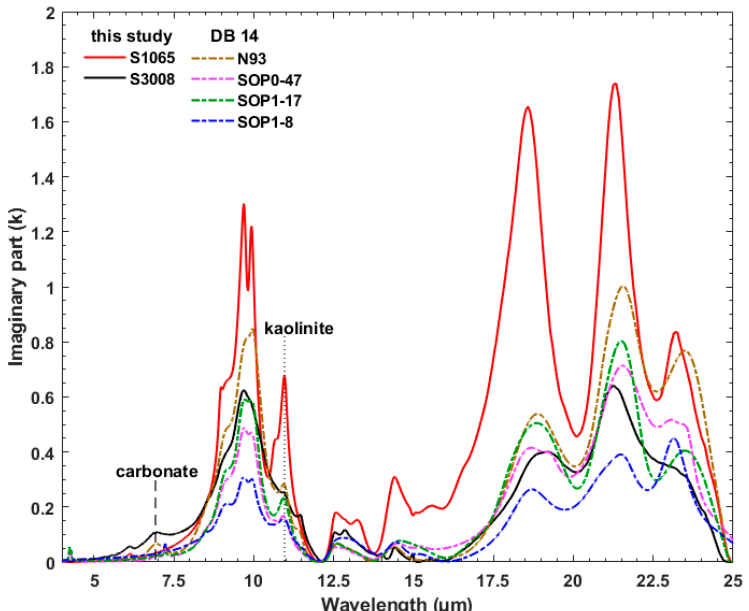
Figure 5. k spectra obtained in this study (solid lines) are compared with those derived by Di Biagio et al. [19] (dash ‐ dot lines). Vertical dashed and dotted lines represent carbonate and kaolinite absorption features near 7 and 10.9 μ m, respectively.